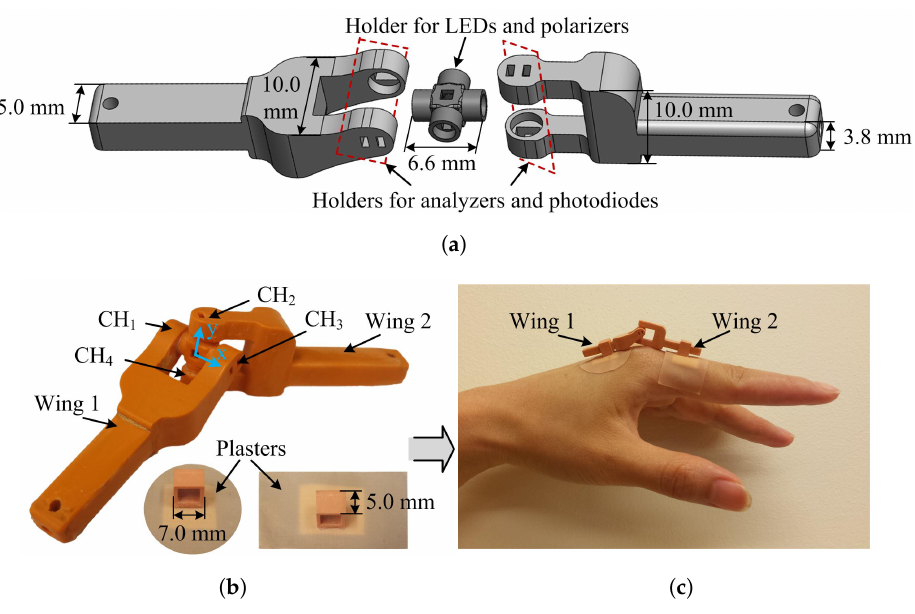
Figure 3. The two-axis optical sensor. ( a ) the 3D design produced in SolidWorks 2015 (DS SolidWorks Corp., Waltham, MS, USA); ( b ) a photograph of the complete optical sensor and the two rectangular hollow parts glued on the adhesive plasters; ( c ) an example of the sensor’s placement on the metacarpophalangeal joint of the left index